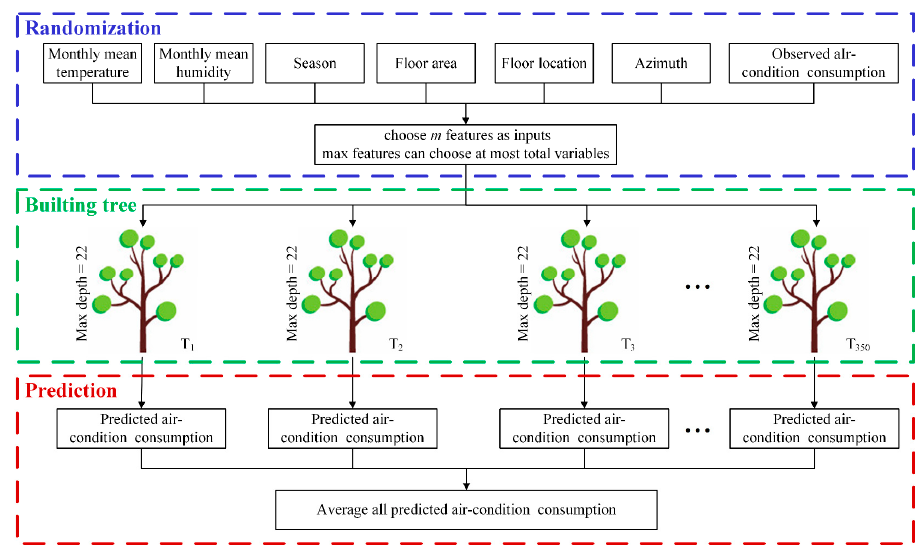
Figure 8. The RF structure with optimal parameters and inputs.